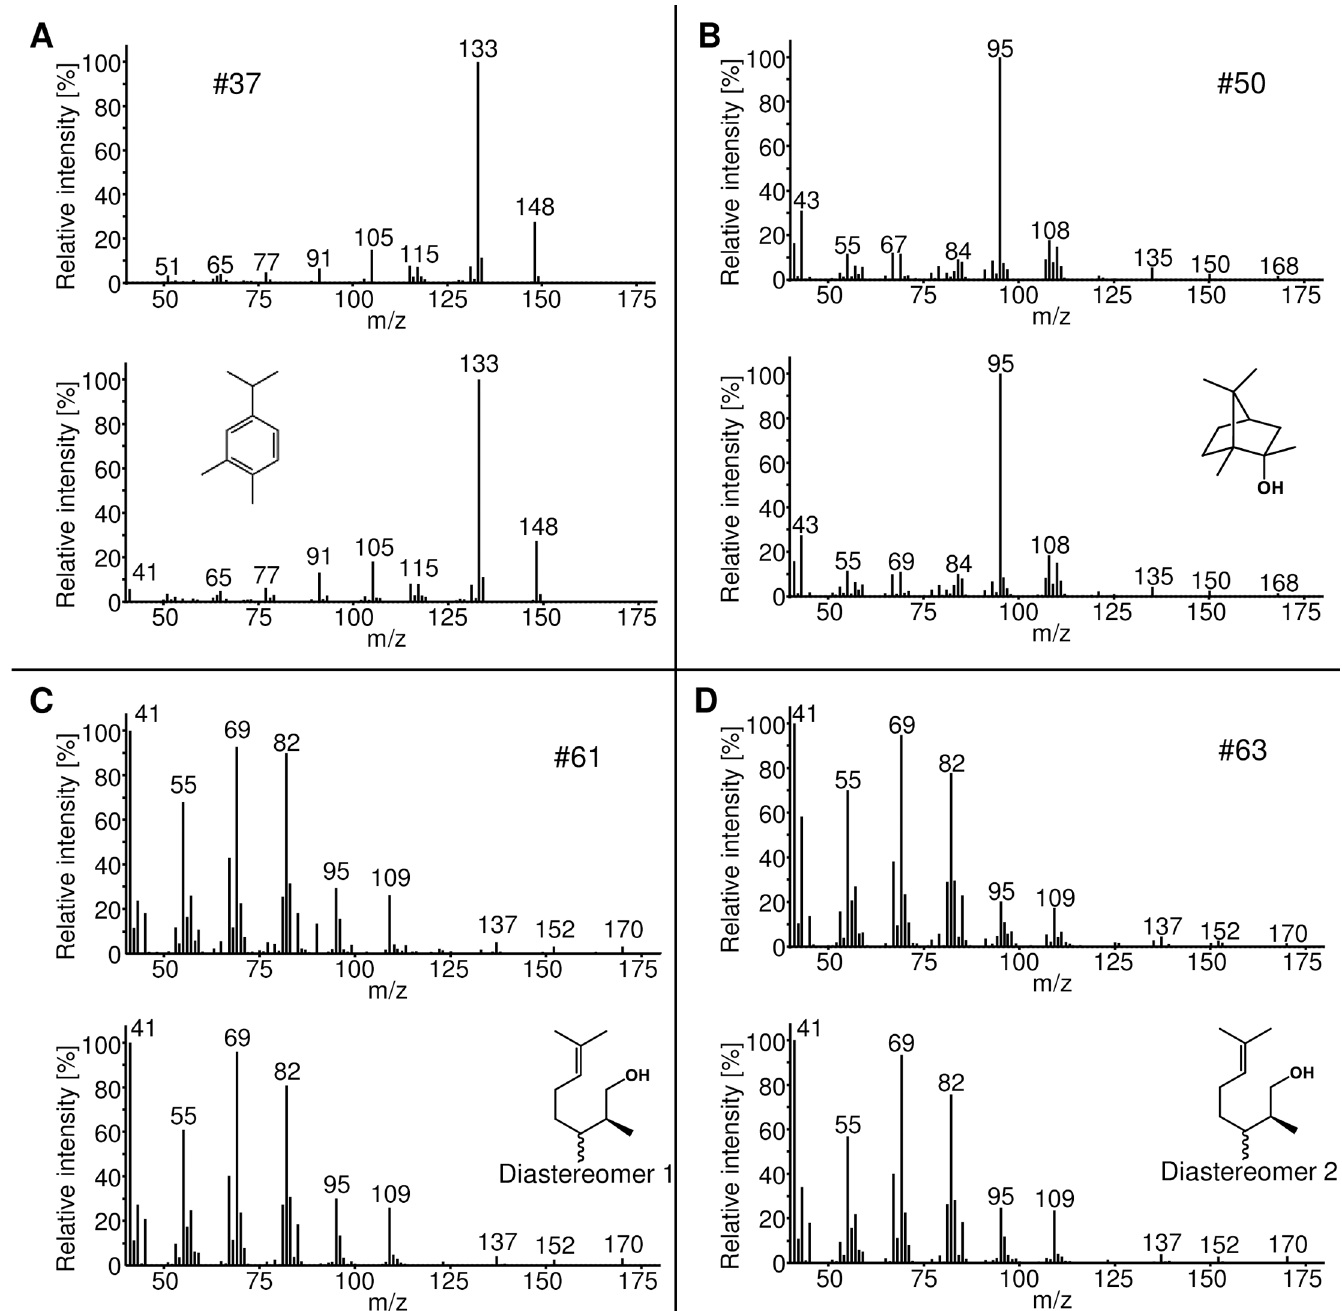
Fig 3. Mass spectra and structures of the four novel C11-TS products 3,4-dimethylcumene (A), 2-methylborneol (B), 2-methylcitronellol diastereomer 1 (C) and 2-methylcitronellol diastereomer 2 (D) The mass spectra obtained from the analyses of the production strains (above) are compared with those of reference compounds (below).The mass spectra of the diastereomers of 2-methylcitronellol are almost identical.